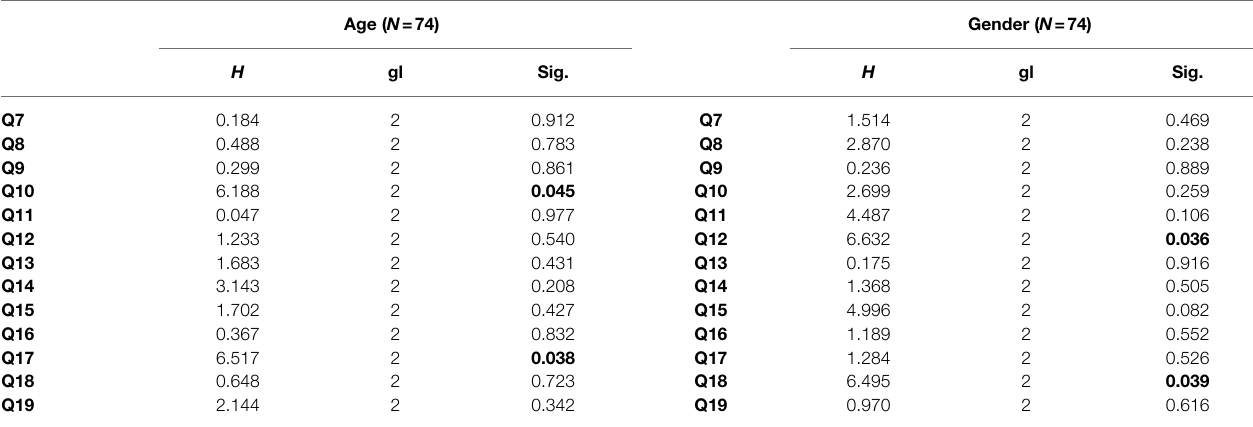
TABLE 4 | Kruskal–Wallis results for variables age and